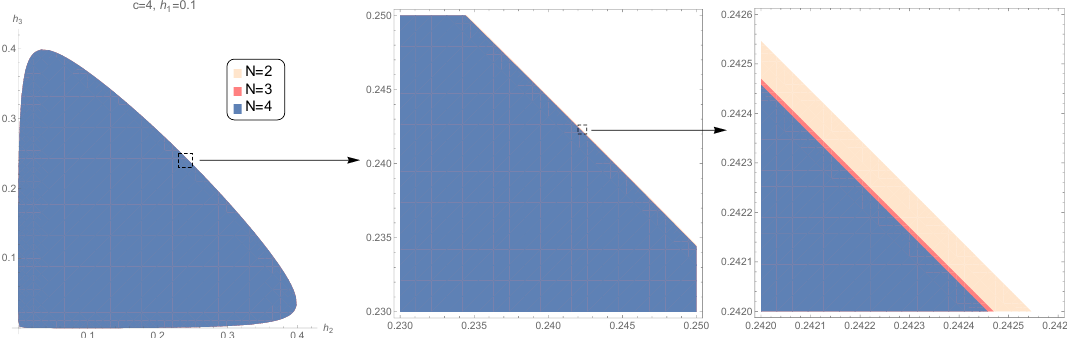
Figure 3 . Top : three-dimensional plots of the domain D (3) cross-sections of these domains for various values of h 1 . The structure constants of primaries with twists ( (cid:28) 1 ; (cid:28) 2 ; (cid:28) 3 ) = (2 h 1 ; 2 h 2 ; 2 h 3 ) outside these critical domains are bounded by those whose twists lie within the domains.